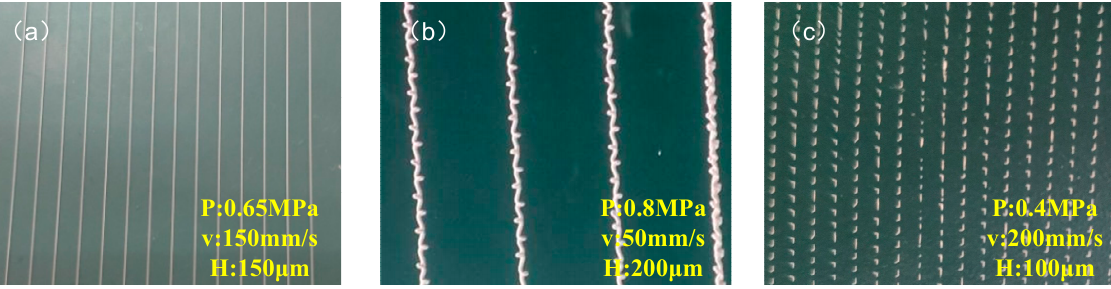
Figure 6. ( a ) Normal situation and actual print failure conditions of ( b ) stacking and ( c ) broken lines.